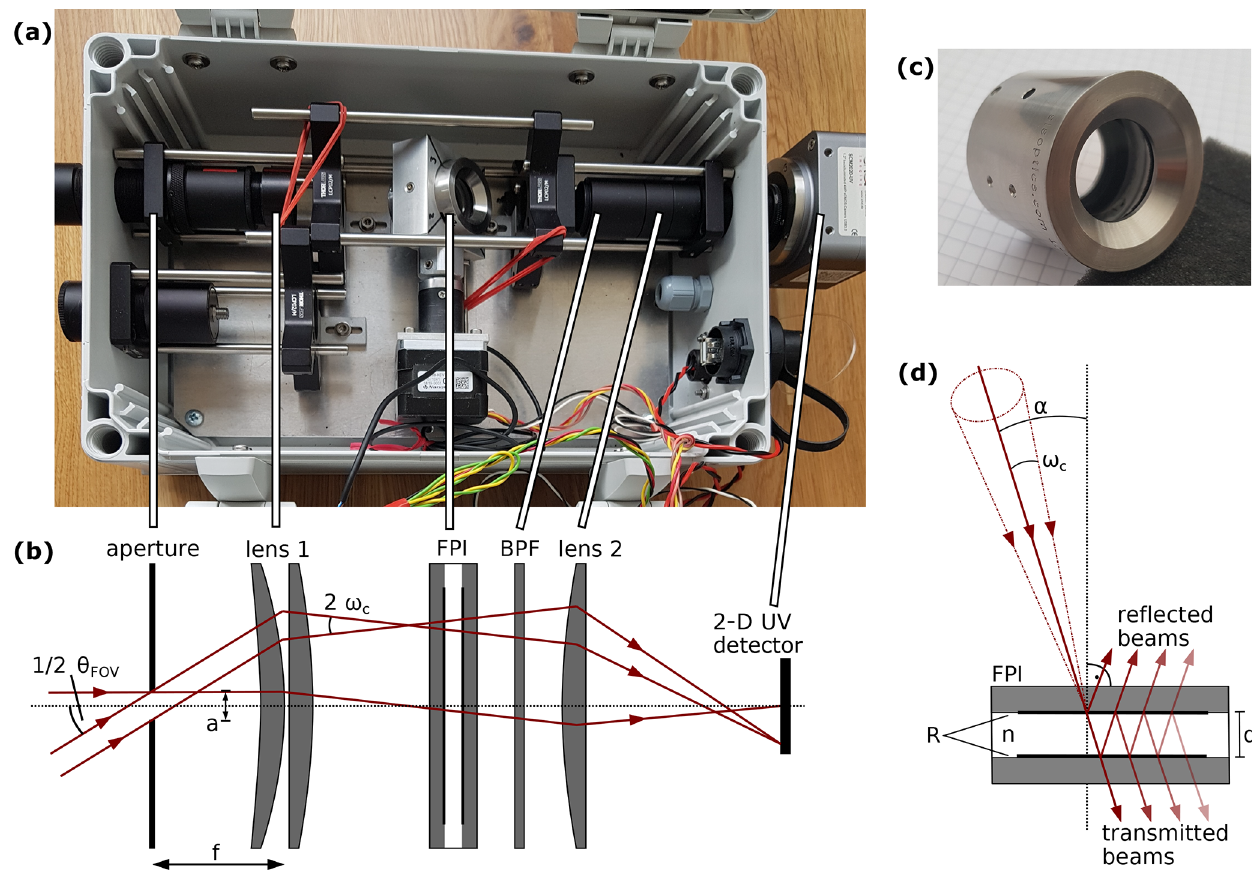
Figure 3. (a) Photograph of the IFPICS instrument. The physical dimensions are 200mm × 350mm × 130mm ( w × l × h ) and 4.8kg. (b) Sketch of the image side telecentric optical setup of the IFPICS prototype. Incident radiation is parallelised by an entrance aperture and lens 1 before traversing the FPI and the band pass filter (BPF). The maximum half cone opening angle ω c is dependent on the aperture diameter a and the focal length f of lens 1. The camera field of view is θ FOV = 18 ◦ . A second lens maps the image onto a 2D UV-sensitive CMOS detector. (c) Photograph of the static air-spaced etalon (FPI) provided by SLS Optics Ltd. (d) Sketch of the FPI. An incoming single beam (drawn red) with incidence angle α is reflected multiple times between the FPI mirrors with reflectance R and separation d . Visualisation of an incoming cone-shaped beam (red dashed–dotted lines), with half cone opening angle ω c and incidence angle α of the cone